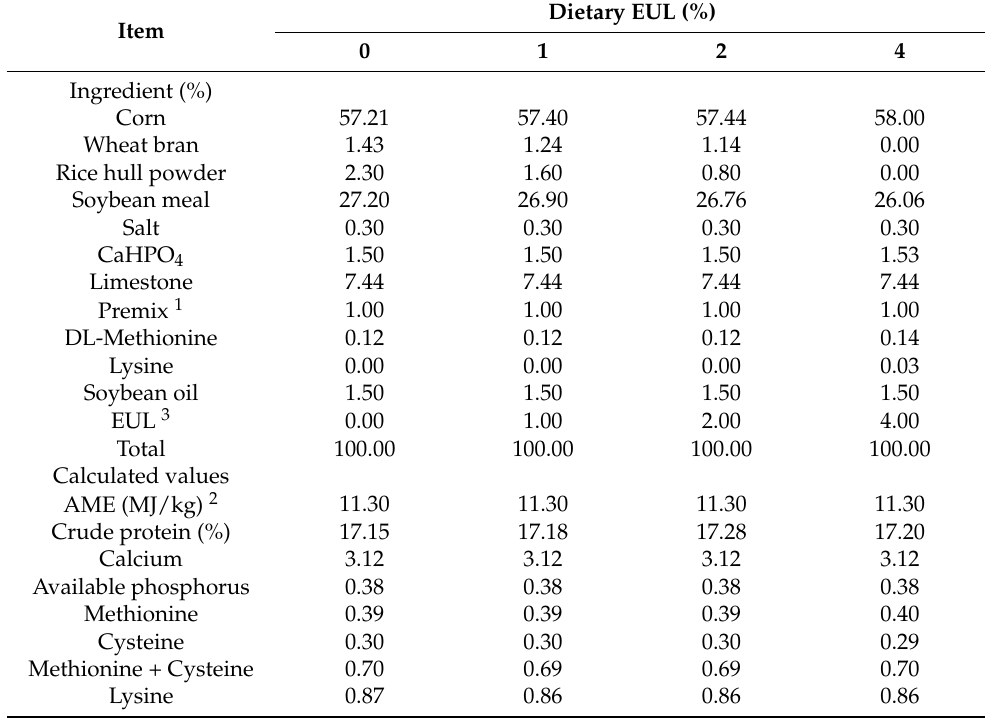
Table 1. Composition and nutrient levels of basal diets for laying ducks (air-dry basis). Item